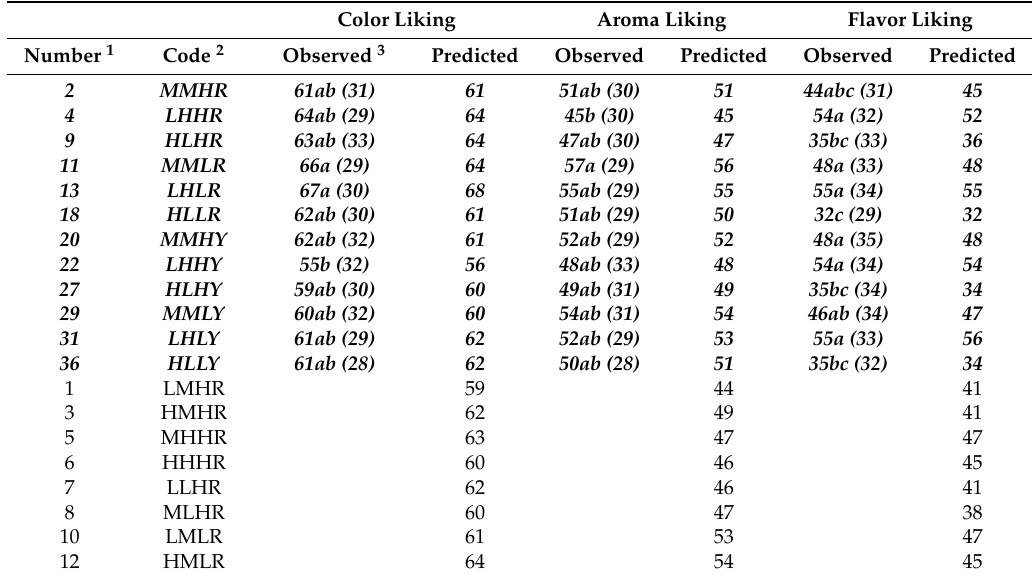
Table 6. Partial least square regression (PLSR) model predicted liking ratings for color, aroma, and flavor of the grapefruit-like